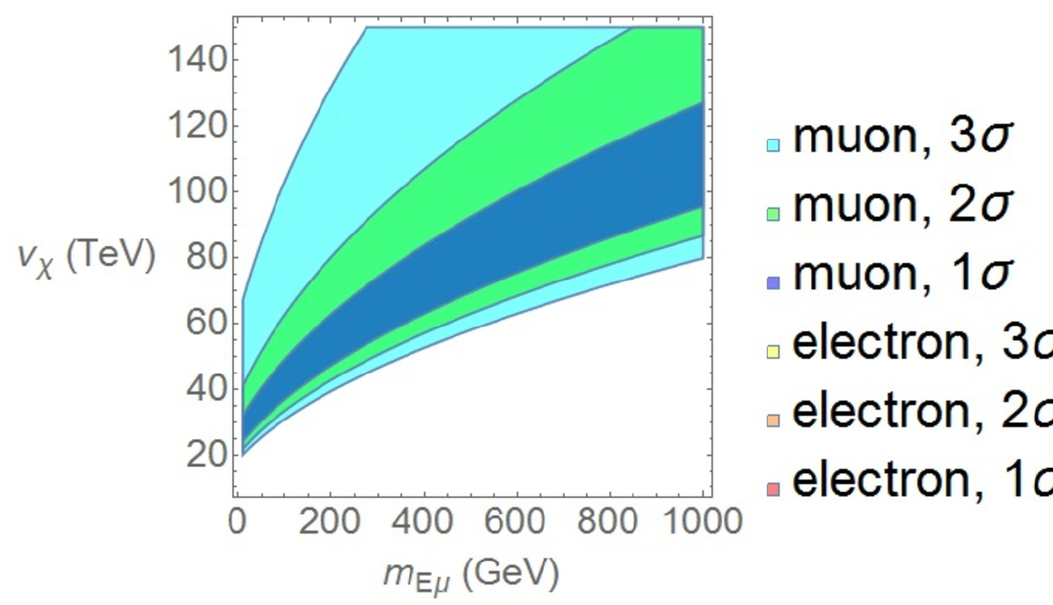
= m E = 500 GeV. e (cid:28) { 13